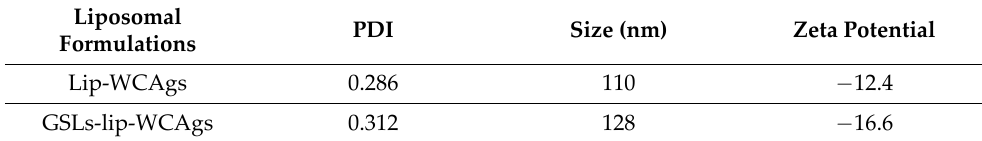
Table 1. Characteristic of liposome formulations.